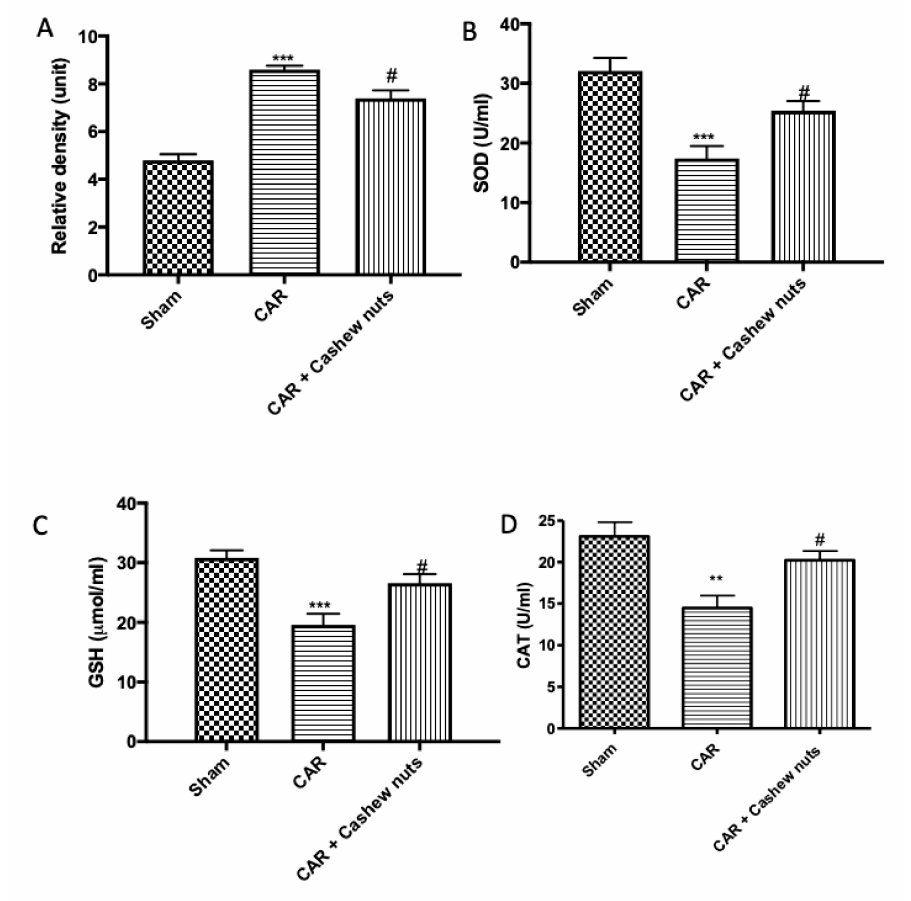
Figure 5. Anti-oxidant e ff ects of cashew nuts after CAR-induction. Oxidative stress is a major component of acute inflammatory condition. First line of defense against free radical production ( A ) is represented by SOD ( B ), CAT ( C ), and GSH ( D ). Administration of cashew nuts at the dose of 100 mg / kg significantly increased the activity of the anti-oxidant enzymes SOD, CAT, and GSH which had been significantly reduced by carrageenan injection. SOD ( A ), CAT ( B ), and GSH ( C ). See materials and methods for further details. # p < 0.05 vs. CAR; ** p < 0.01 vs. sham; *** p < 0.001 vs.